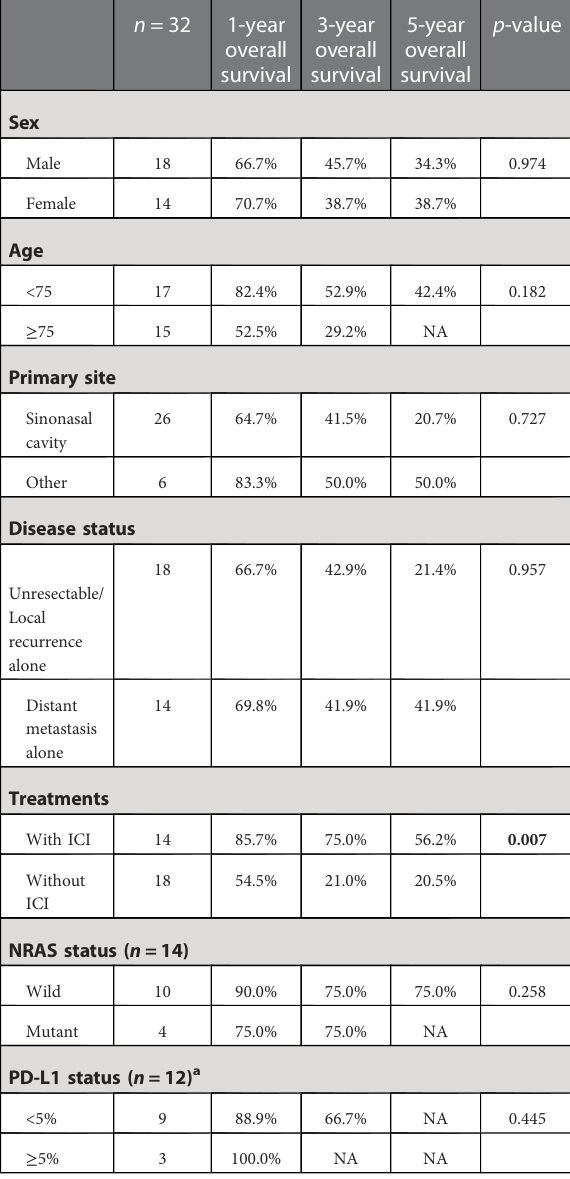
TABLE 3 Clinical parameters associated with OS in patients with advanced HNMM.